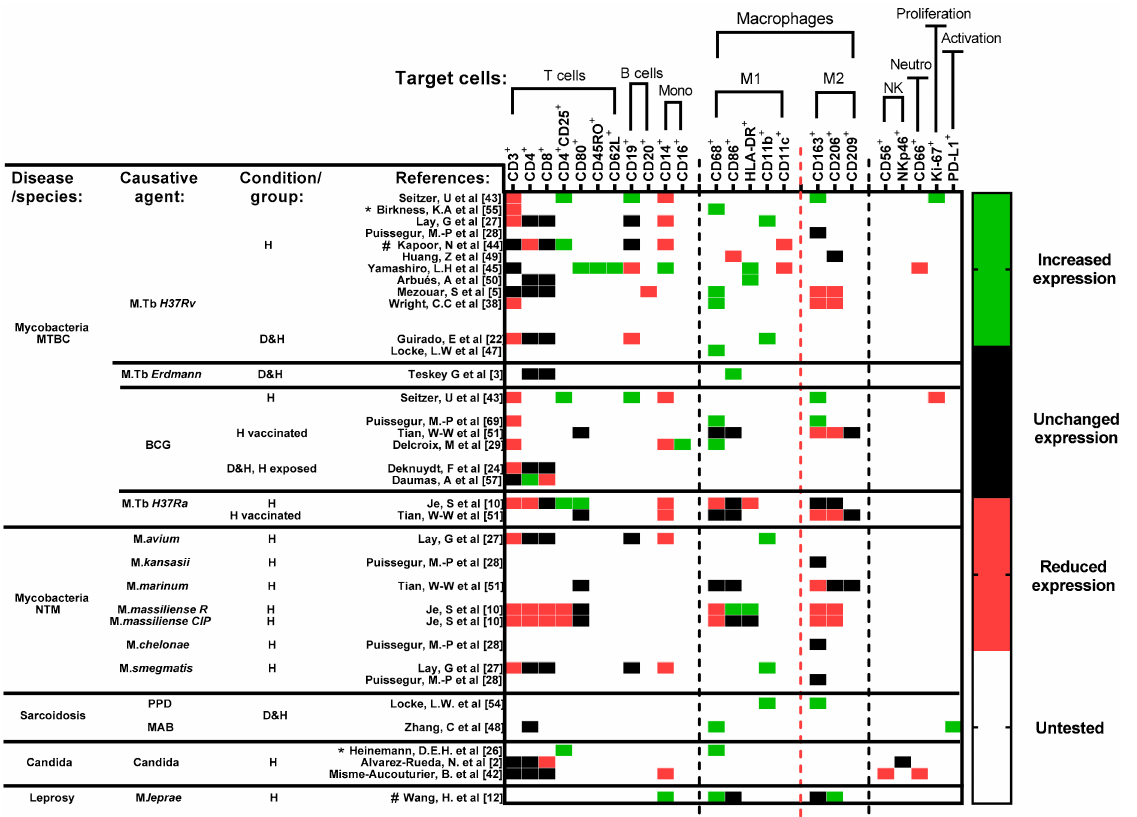
Figure 5. Cell surface markers’ expression profile of included studies. Studies are sorted horizontally according to disease and choice of antigens. Studies focused on mycobacterial diseases are further sorted top-down, based on the virulence of respective strains/species (Table S2). Due to the differences in data presentation and study populations included in each study, any change in expression reflects a significant difference ( p < 0.05) observed in their respective studies, when compared with either an unexposed condition or directly with a healthy control. Untested (white) refers to markers that were not included per study. Timepoint of comparison across results is always relative to the end of experiment determined in each study. Abbreviations—MTBC: Mycobacterium tuberculosis complex; NTM: non-tuberculous mycobacterial species.; BCG: Bacillus Calmette–Gu é rin; PPD: purified protein derivative; MAB: Mycobacterium abscessus ; D: diseased; H: healthy; Mono: monocytes; NK: Natural killer cells; Neutro: neutrophils; *: heat-killed strains/species; # : studies that included cell surface markers for microscopic localization and flow cytometric analysis. Reference number per study are included in